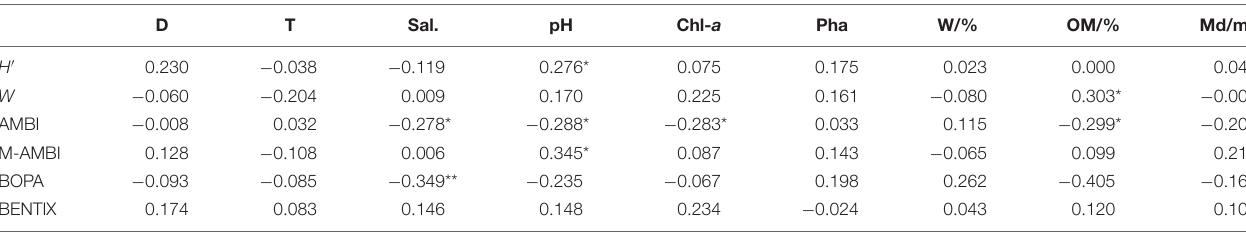
TABLE 2 | Correlation analysis among biotic indices and environmental variables in Jiaozhou Bay. D T Sal.